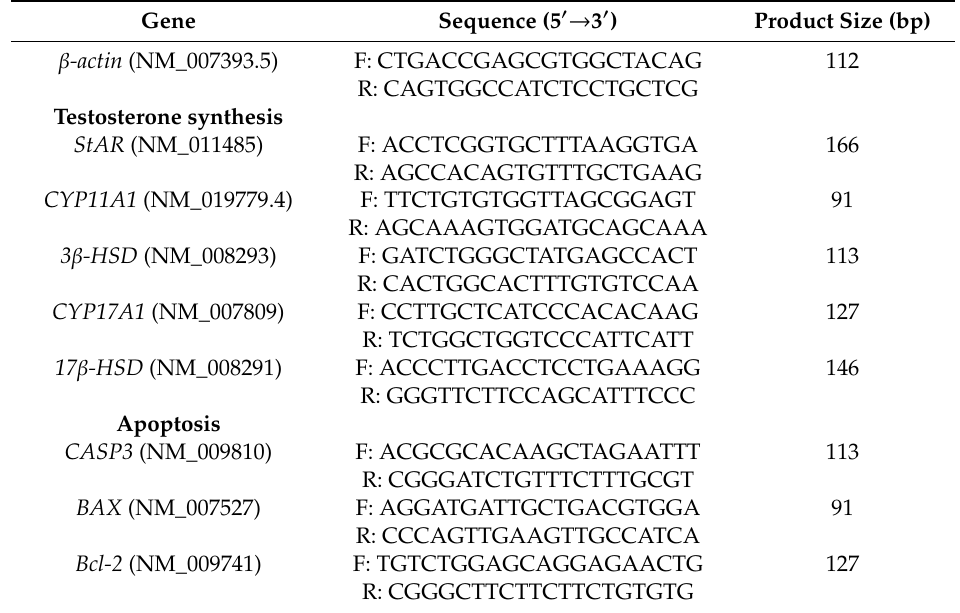
Table 1. The list of primers for analyzed